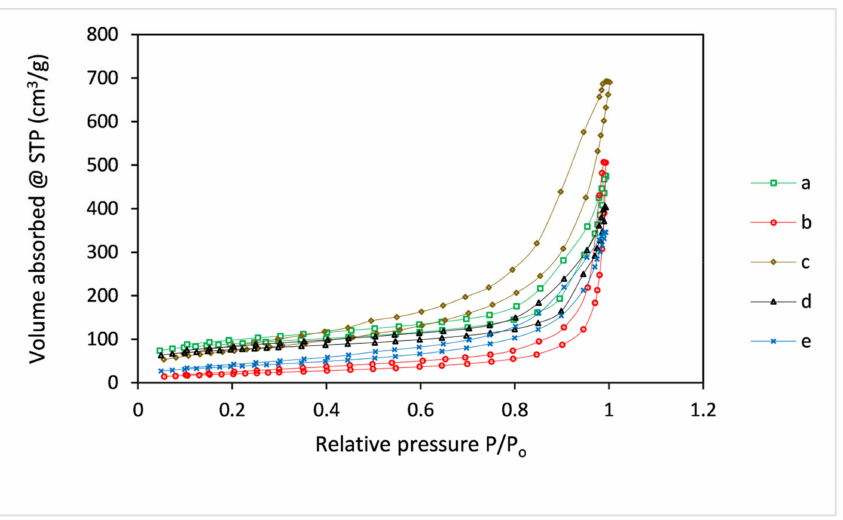
Figure 5. (e) SiO 2